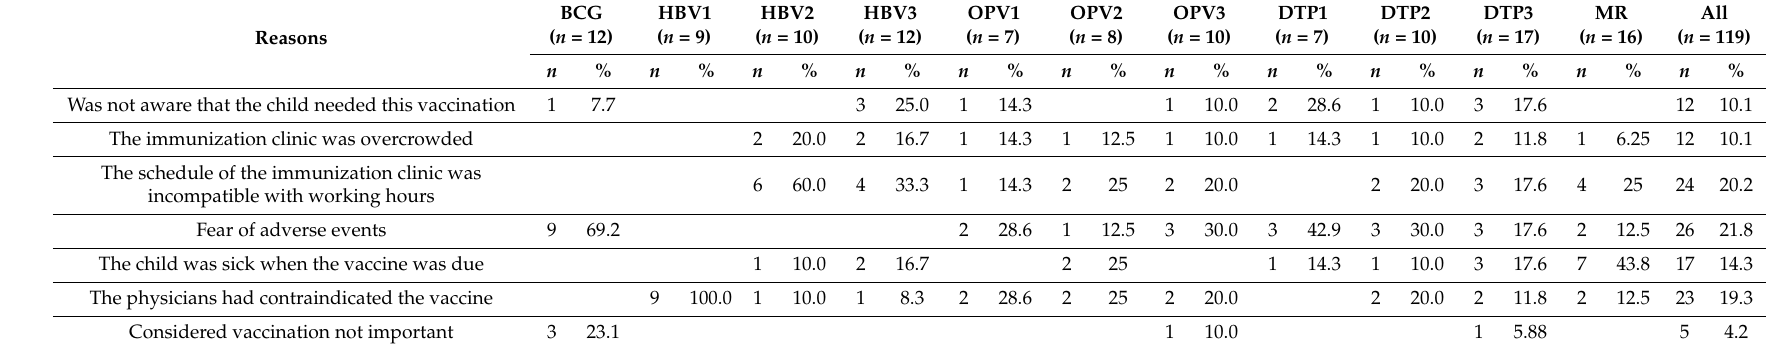
Table 3. Reasons for non-vaccination among children aged 24–36 months, in Zhejiang province.